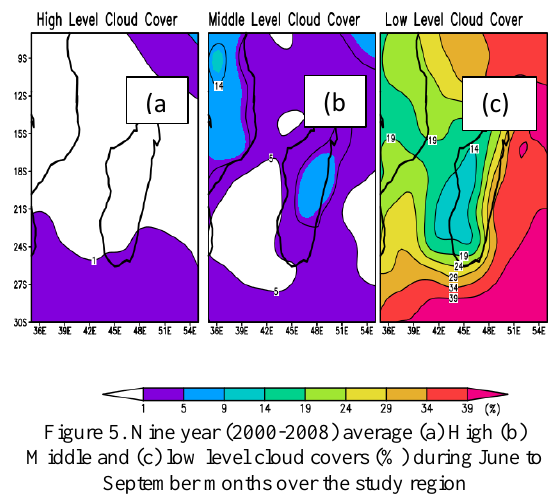
Figure 5. Nine year (2000-2008) average (a) High (b) Middle and (c) low level cloud covers (%) during June to September months over the study